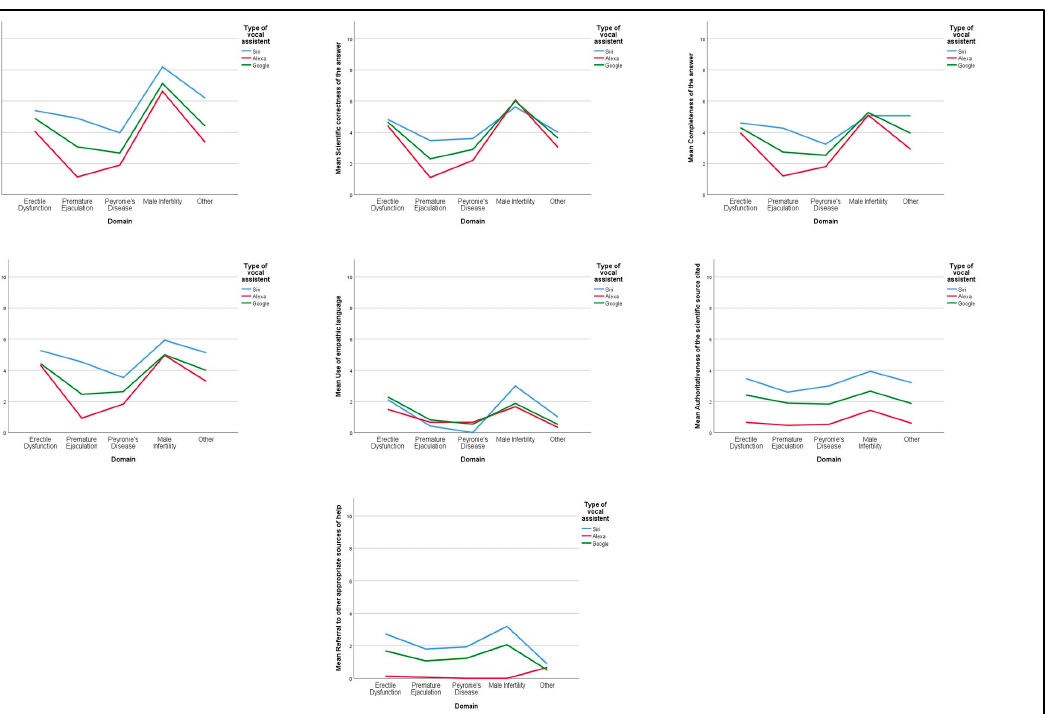
Figure 1. Mean scores of VAs according to the response domains. VA: Voice Assistant.